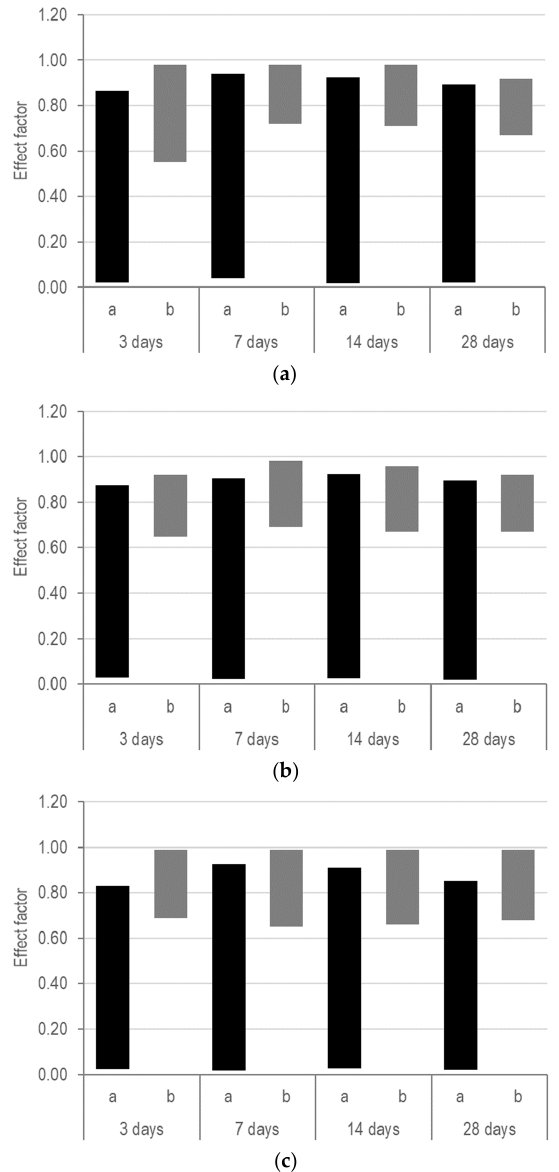
Figure 10. Common ranges of the effect factors for ( a ) W170, ( b ) W160, and ( c ) W150 mixtures at different ages ( a < b < c , c = 1). For the W160 mixtures, the value of a was in the range of 0.03 to 0.88, whereas that of b was 0.65 to 0.92 at an age of 3 days. Furthermore, at an age of 7 days, the value of a was in the range of 0.02 to 0.90, whereas that of b was 0.69 to 0.98, indicating that the influence of CS on the compressive strength was more significant than at 3 days. At an age of 14 days, the value of a was in the range of 0.03 to 0.92, whereas that of b was 0.67 to 0.96. Finally, at an age of 28 days, the value of a was in the range of 0.02 to 0.89, whereas that of b was 0.67 to 0.92. For the W150 mixtures, the value of a was in the range of 0.03 to 0.83, whereas that of b was 0.69 to 0.99 at an age of 3 days. Furthermore, at an age of 7 days, the value of a was in the range of 0.02 to 0.93, whereas that of b was 0.65 to 0.99, indicating that the influence of DS on the compressive strength was more significant than at 3 days. At an age of 14 days, the value of a was in the range of 0.03 to 0.91, whereas that of b was 0.66 to 0.99, which were similar to the ranges at 7 days. Finally, at an age of 28 days, the value of a was in the range of 0.02 to 0.85, whereas that of b was 0.68 to 0.99, indicating that the influence of DS on the compressive strength decreased slightly compared with the results at 7 and 14 days. Based on the obtained values, the common ranges of a and b were obtained for all ages. For the W170 mixtures they were 0.04 to 0.86 and 0.72 to 0.92, respectively; for the W160 mixtures they were 0.03 to 0.88 and 0.69 to 0.92, respectively; and for the W150 mix- tures they were 0.03 to 0.83 and 0.69 to 0.99, respectively, indicating that the influence of CS on compressive strength was slightly more significant compared to the other mixtures